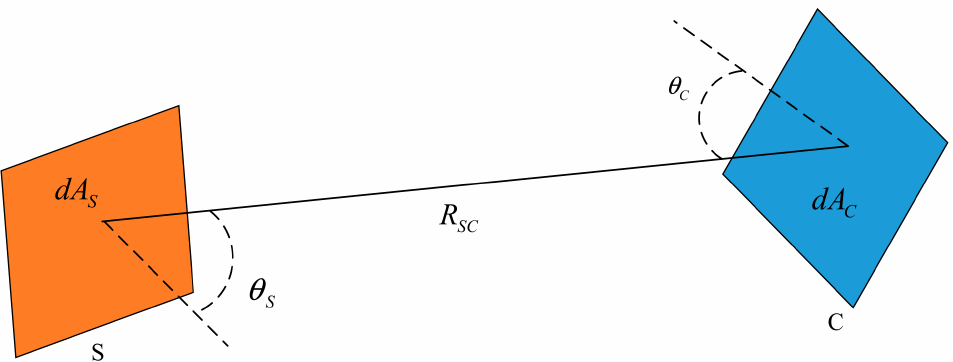
Figure 3. Radiation transfer